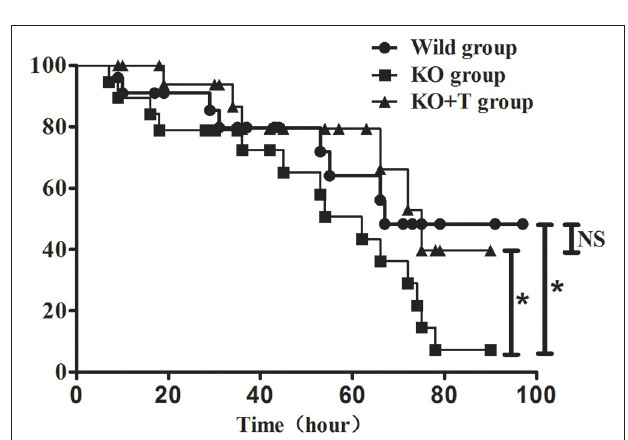
FIGURE 6 | Effect of IL17- γδ T cells on the survival rate of mice with pulmonary P. aeruginosa infection. Mice in the four groups were inoculated with 20 µ l PAO1 (1 × 10 10 CFU ml − 1 ). Eighteen to twenty mice in each group were observed at least every 8 h until the fourth day post infection. * p < 0.05. These results represent three independent